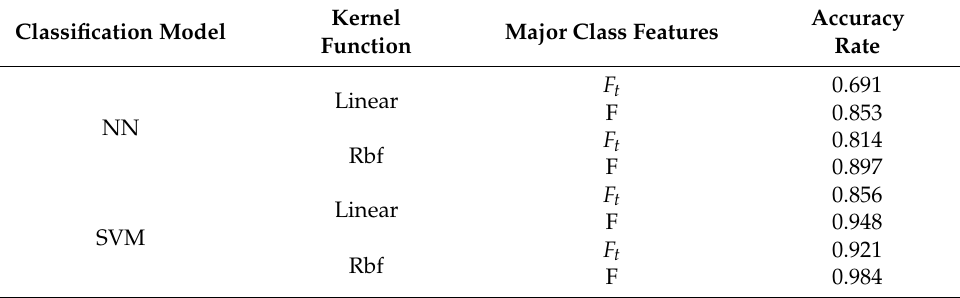
Table 3. Comparison of the effects of classification